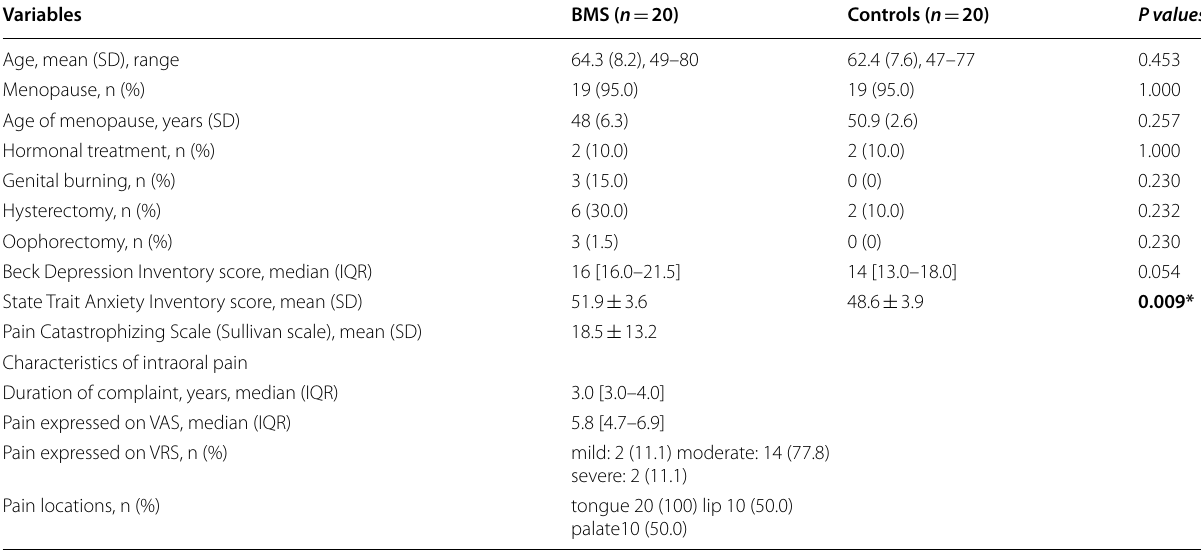
Table 2 Mechanical and thermal pain thresholds and pain rating